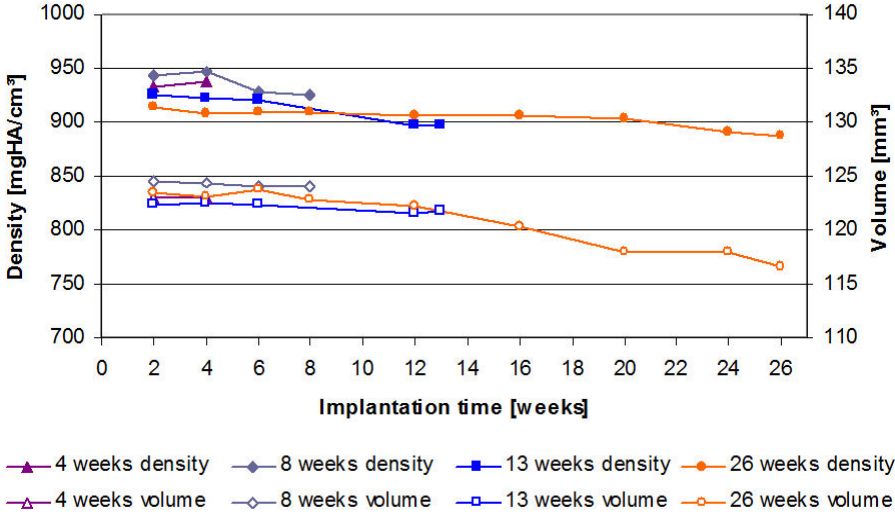
Figure 2. µ-computed tomographically educible reductions of implant volumes (open symbols) and densities (full symbols) of the LANd442-implants introduced into the rabbits’ tibiae plotted against the test period of up to 26